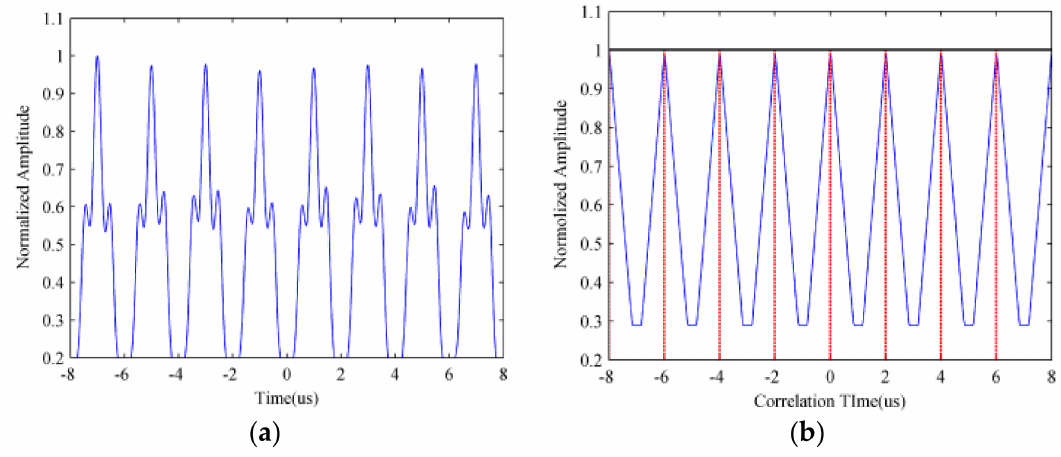
Figure 8. Estimation result by applying correlation detection. ( a ) The summation of the STFT along the frequency; ( b ) the autocorrelation result of STFT